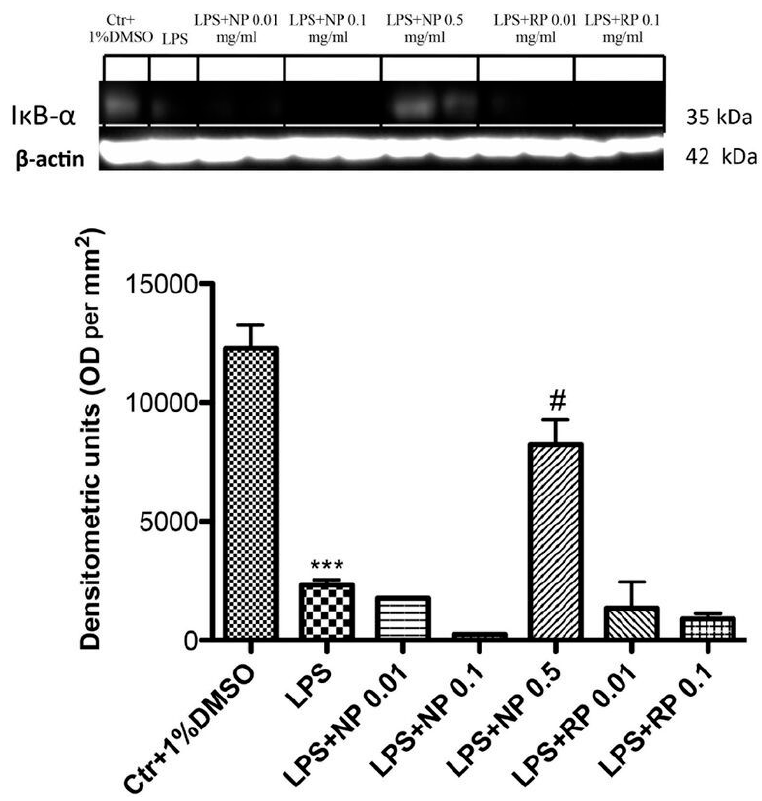
Figure 2. Effect of NP and RP on I κ B- α expression. Western blot analysis demonstrated basal levels for I κ B- α in the control group, whereas stimulation with LPS significantly induced the degradation of I κ B- α levels. Treatments with NP at the concentration of 0.5 mg/mL and RP at 0.1 mg/mL increased the levels of I κ B- α , but this protection was not significant. Data are representative of at least three independent experiments; *** p < 0.001 vs. Ctr; # p < 0.05 vs. LPS.